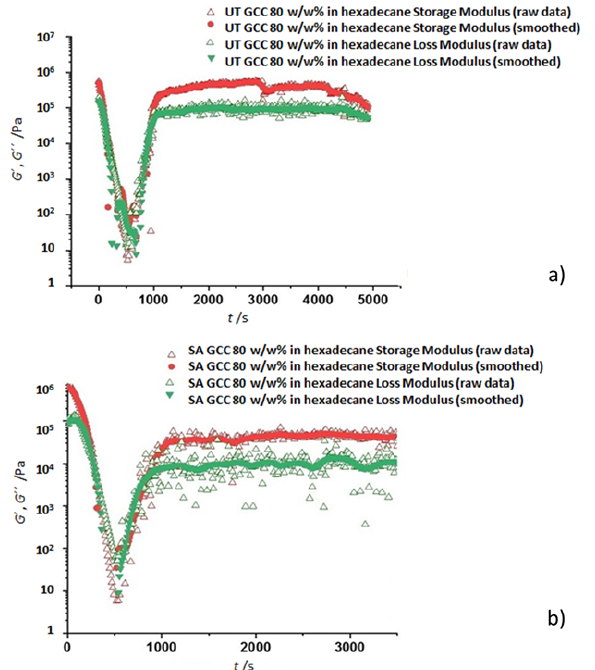
Figure 7: Viscoelastic stress moduli reduction and recovery under oscillation as strain is ramped up and then down – finally measure- ments continue under conditions of constant low-level strain: (a) untreated UT GCC at 80 w/w% solids in hexadecane, (b) fatty acid treated SA GCC at 80 w/w% solids in hexadecane.